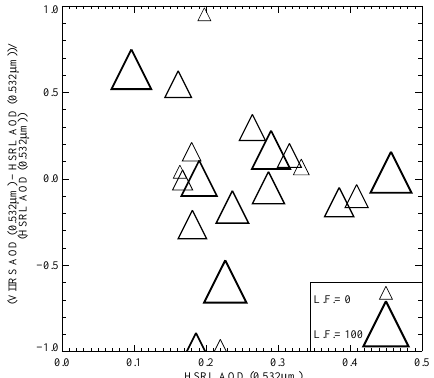
Figure 8. Relative error of each VIIRS τ retrieval (interpolated to 0.532µm) with respect to HSRL-retrieved total-column τ , plotted as a function of the HSRL retrieval. The lunar fraction (on a scale of 0–100) is indicated by plot symbol size, as shown by the key in the bottom right